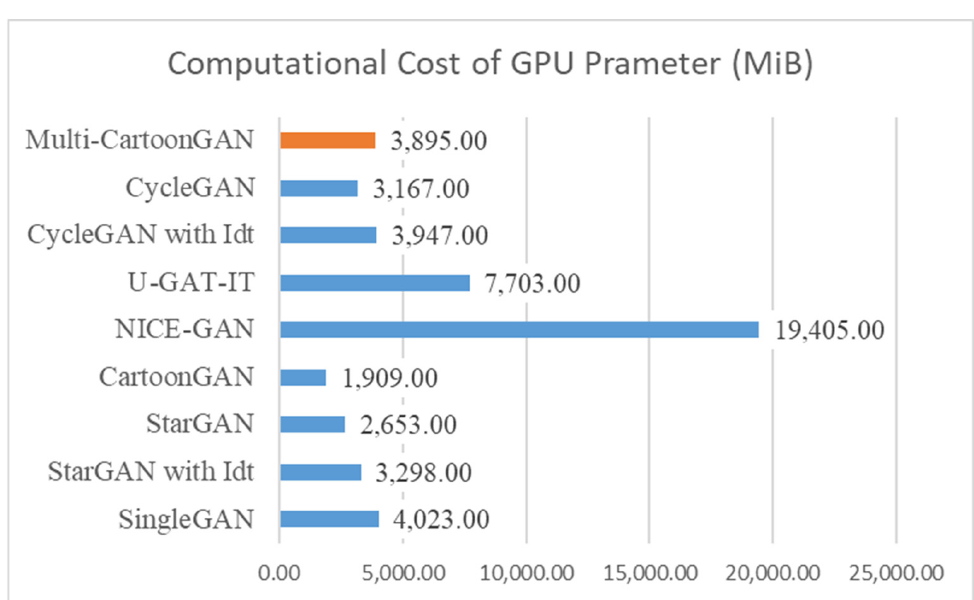
Figure 7. Comparing the time to complete one training epoch (Idt refers to the model learned iden- tity mapping for preventing extreme color tinting).